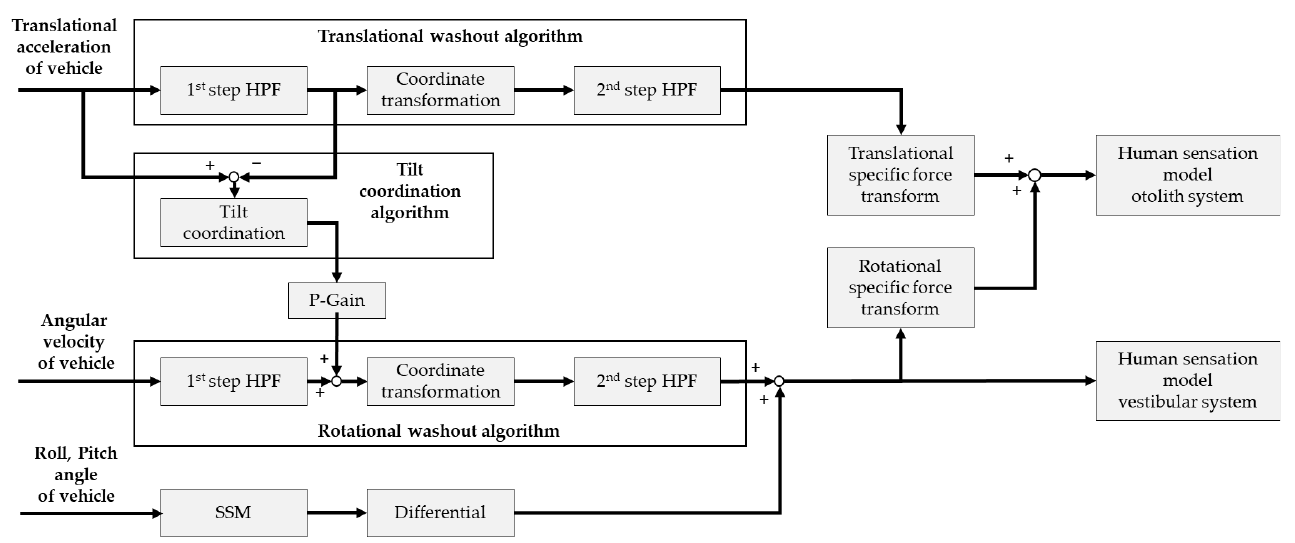
Figure 12. Simulation diagram for the motion sensation by the classical washout algorithm.